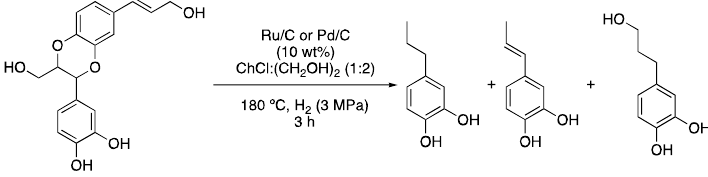
Figure 5. Hydrogenolysis of benzodioxane derivative.